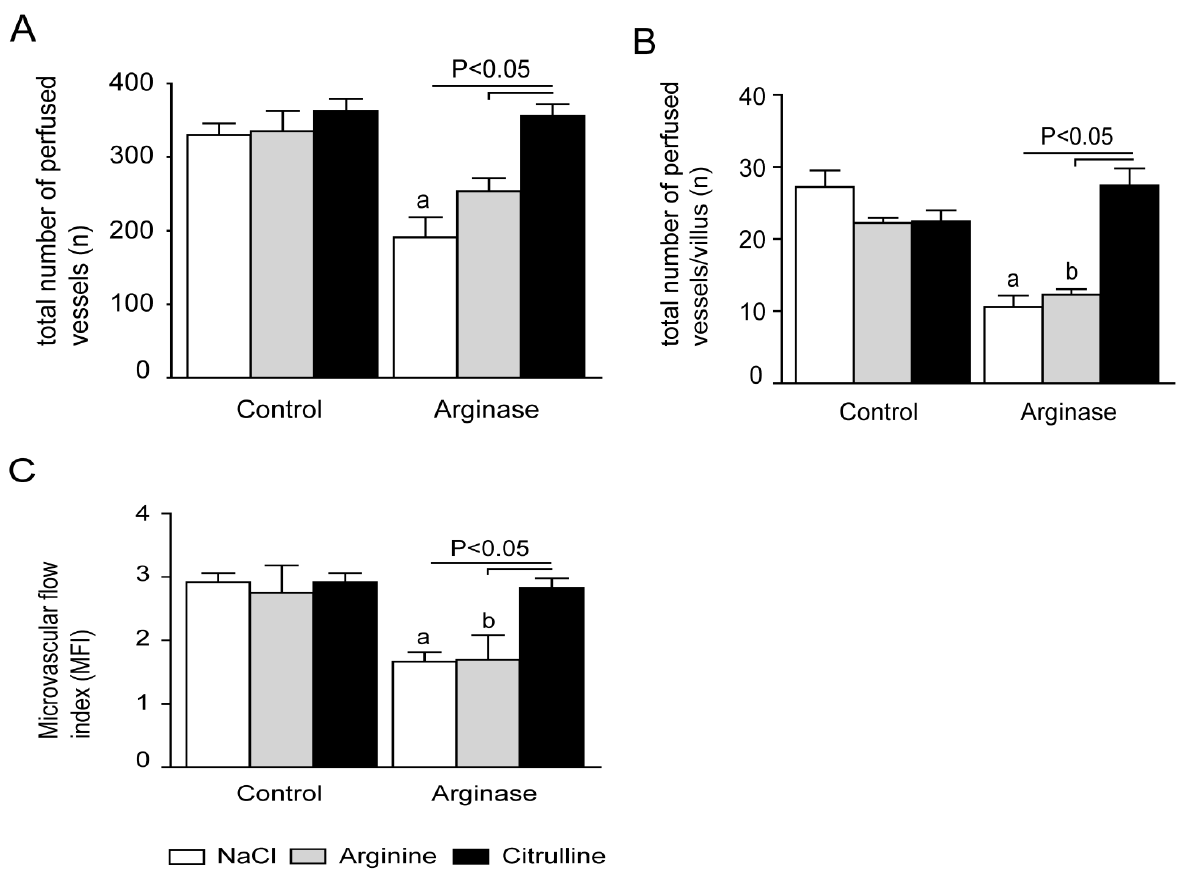
Figure 9. Microcirculatory measurements with side stream dark-field (SDF)-imaging in the jejunal villi. ( A ) The total number of perfused vessels measured with SDF-imaging in the jejunal villi was significantly decreased in arginase-treated mice compared to the control and after L -citrulline supplementation in arginase-treated mice. ( B ) The number of perfused vessels per villus was in line with the total number of perfused vessels, as arginase-treated mice exhibited significantly less perfused vessels per villus compared to control